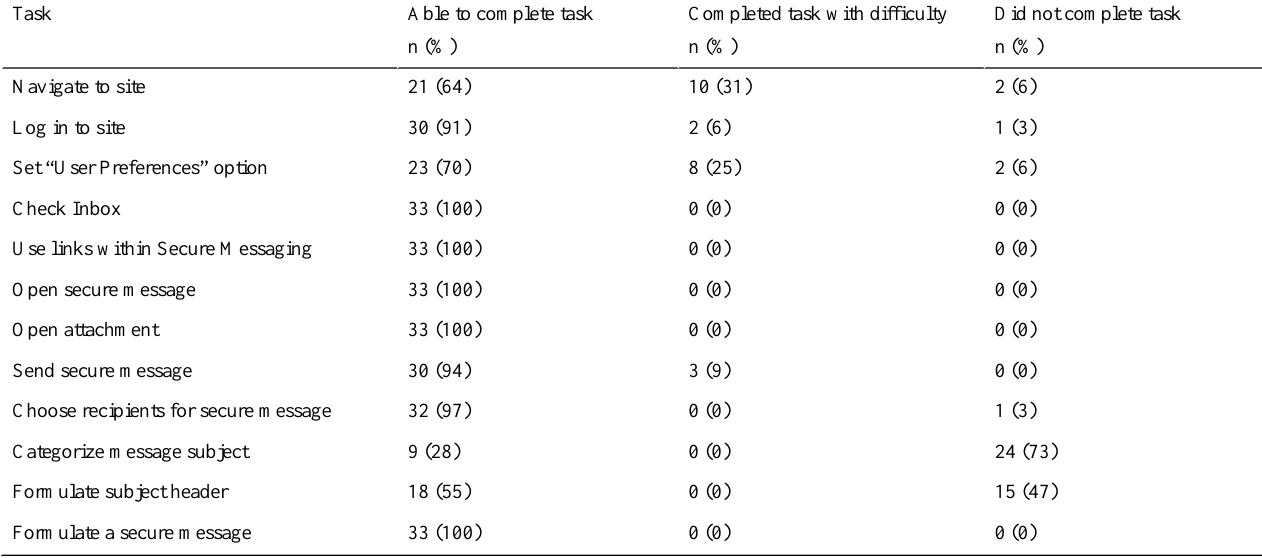
Table 8. User-testing findings (n=33).